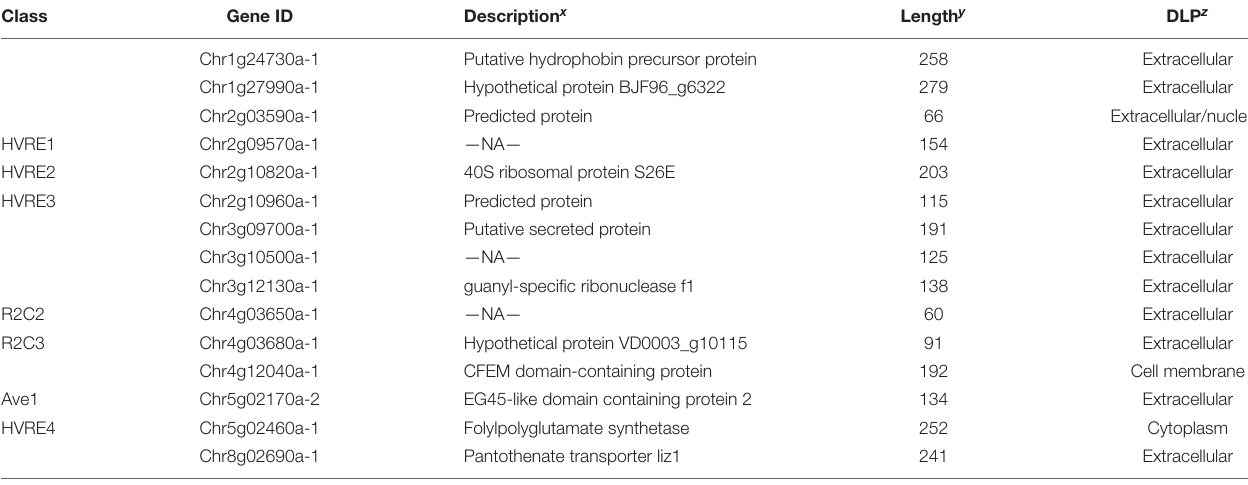
TABLE 4 | Gene ontology and cellular localization analysis of effectors present in HVRs, or with missing coding sequences due to indels, of 18 V. dahliae genomes. Class Gene ID